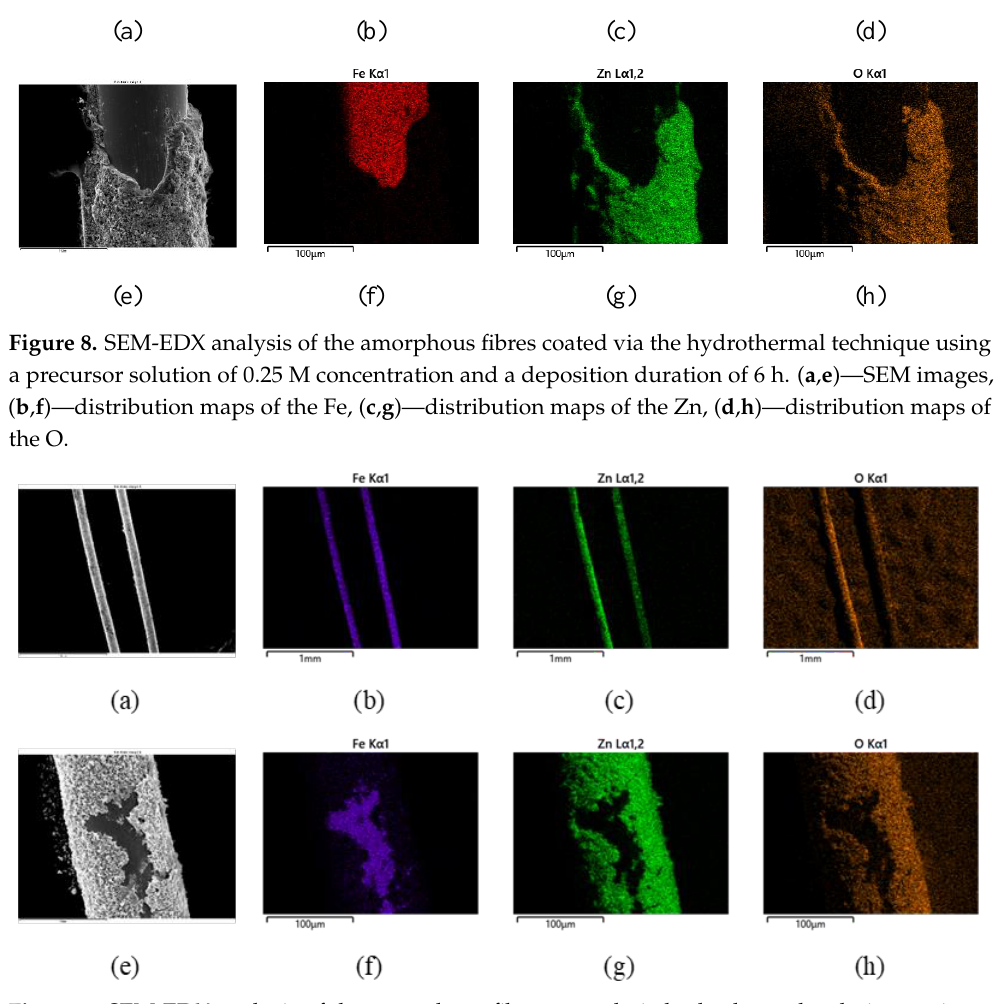
Figure 9. SEM-EDX analysis of the amorphous fibres coated via hydrothermal technique using a precursor solution of 0.1 M concentration and a deposition duration of 6 h. ( a , e ) are SEM images of the plane and semi-circular surface of the fibres; ( b – d ) and ( f – h ) are distribution maps of the Fe, Zn and O on the plane and semi-circular surface of the